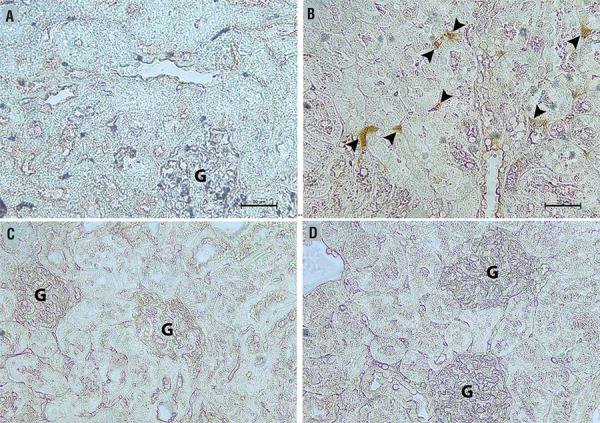
(A-D) - Representative photo micrographs of Mac387 immuno histochemistry of the renal cortex in the sham group (a) and sepsis group (b) 5mg/kg (c) and 10mg/kg tadalafil+sepsis groups (d).(a) and sepsis group (b) 5mg/kg (c) and 10mg/kg tadalafil+sepsis groups (d). Arrows indicate areas of inflammatory cell infiltration.